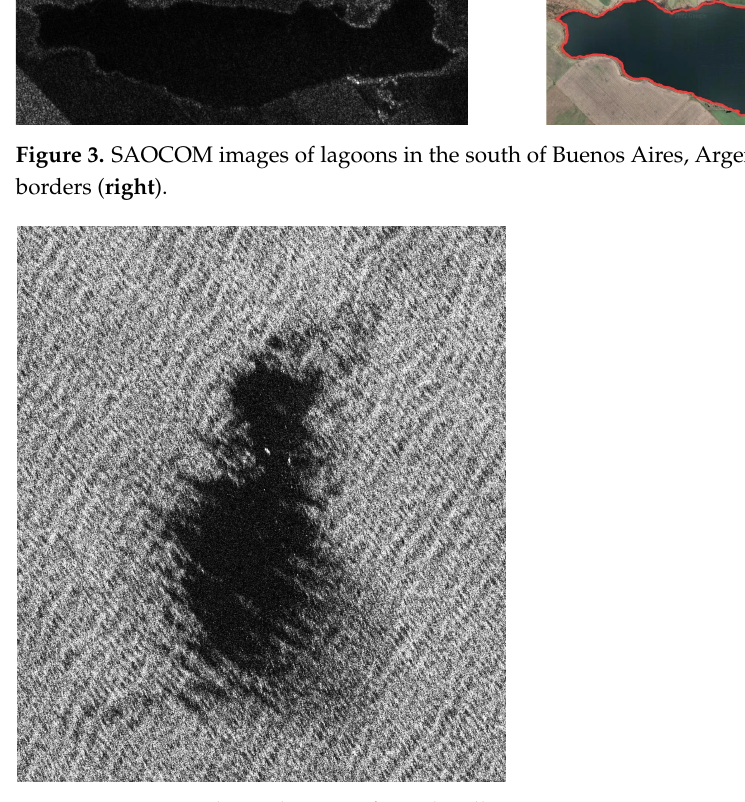
Figure 4. COSMO-SkyMed image of an oil